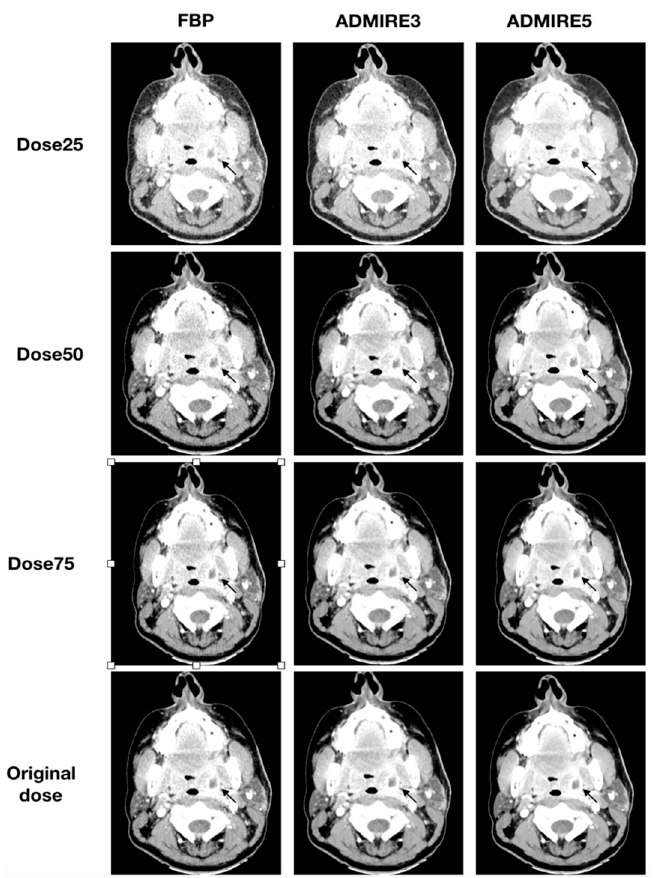
Figure 6. Axial tomographic slices of a 46 year old female patient with left-sided peritonsillar abscess (arrow). All images were reconstructed with FBP, ADMIRE 3, and ADMIRE 5 (from left to right) at 75%, 50%, and 25% dose reduction of the original dose. Reader 1 missed the abscess in reconstruction mode FBP at a dose of 25%.